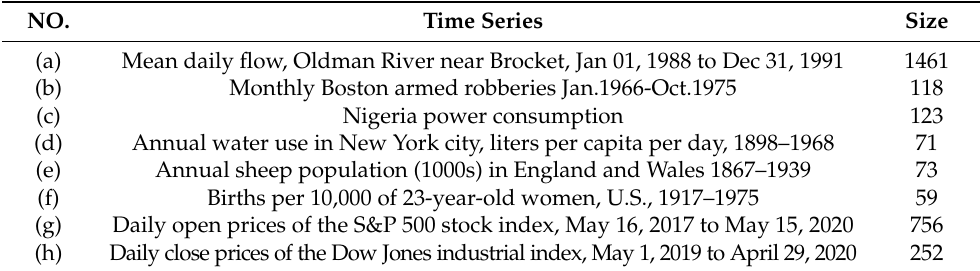
Table 1. Experimental